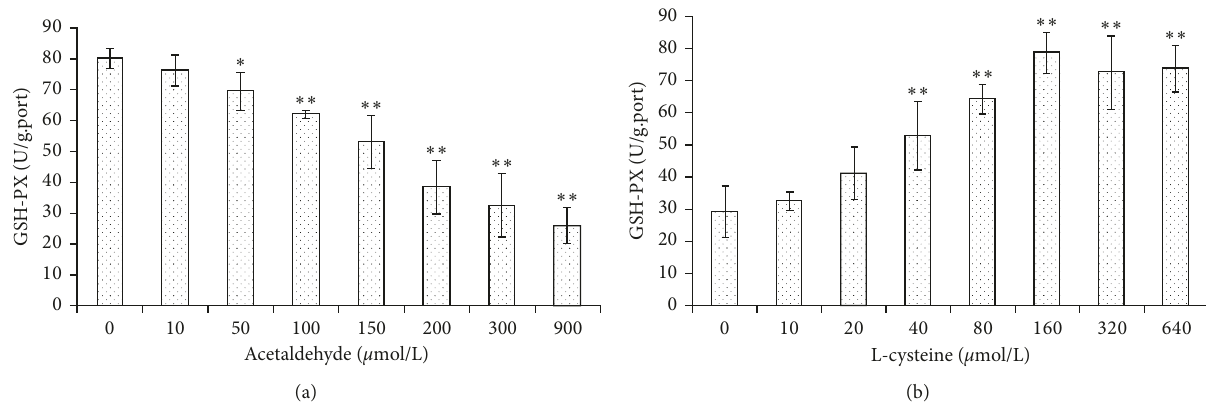
Figure 2: GSH-Px activity of A549 cells influenced by acetaldehyde (a) and influence of L-Cys on the GSH-Px activity of A549 cells damaged by 200 μ mol/L acetaldehyde (b). Data are represented as the mean control group.